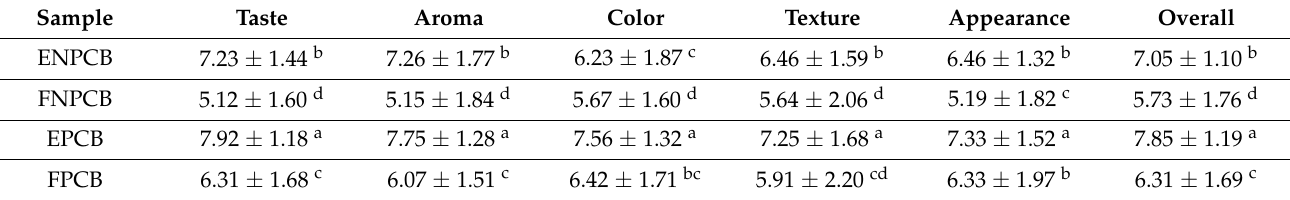
Table 9. Sensorial characteristics of optimums gluten-free cereal